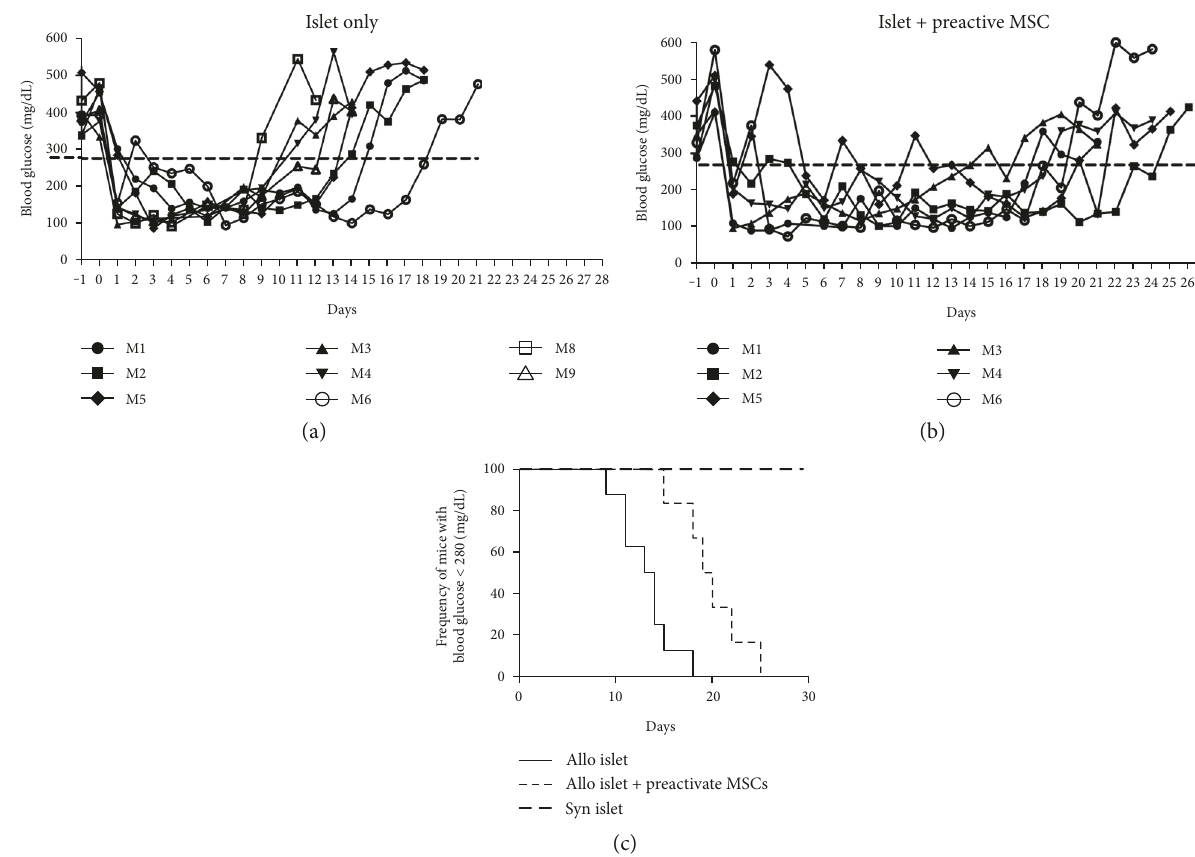
Figure 5: Cotransplantation of preactivated MSCs prolongs islet graft survival in mice. Blood glucose concentration was measured daily in the mice transplanted with 300 islets alone (a) ( n = 8 ) or 300 islets + 2 × 10 5 preactivated MSCs (b) ( n = 6 ). Graft rejection was con fi rmed after two consecutive blood glucose measurements above 280mg/dL. The percentage of normoglycemic mice overtime was compared between the groups (c). Average rejection time of the islet alone group was 13.12 ± 2.80 days compared to 19.83 ± 3.43 in the islet + preactivated MSCs. The mice transplanted with syngeneic islet ( n = 3 ) remained normoglycemic for at least 30 days after transplantation. P < 0 0021 , log-rank